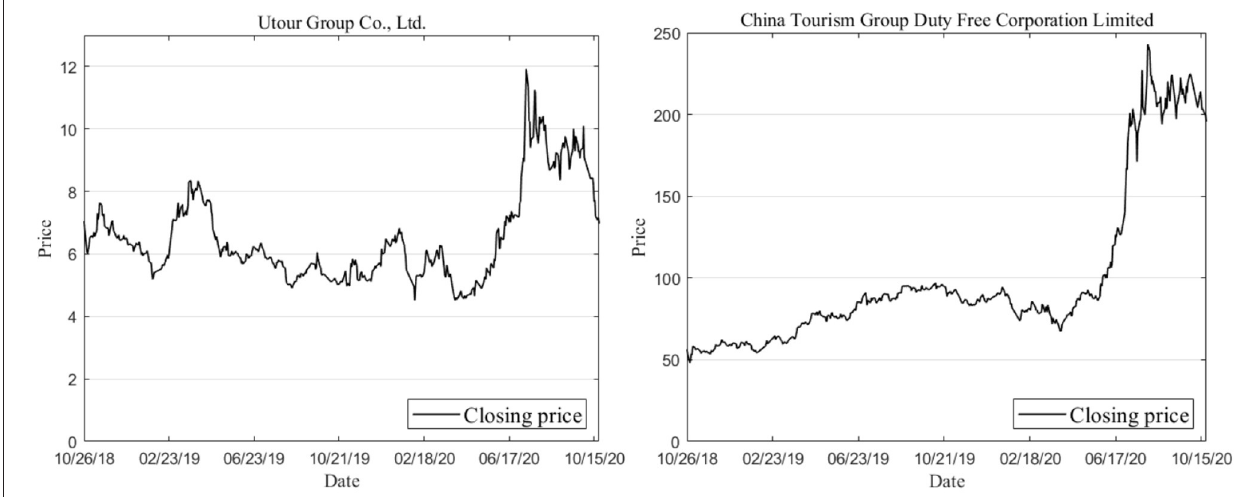
FIGURE 2 | Movement of closing prices of two